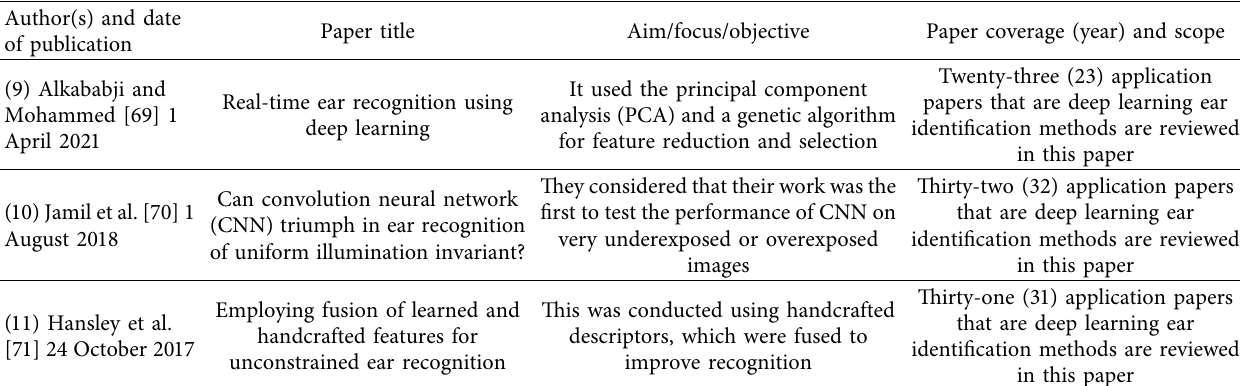
Table 9: Cont. differences between this review article and the recent/existing review